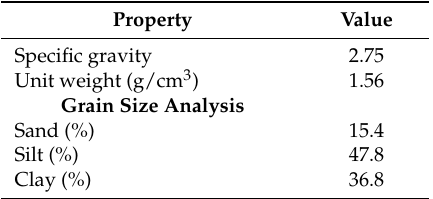
Table 1. Basic properties of Hefei clayey